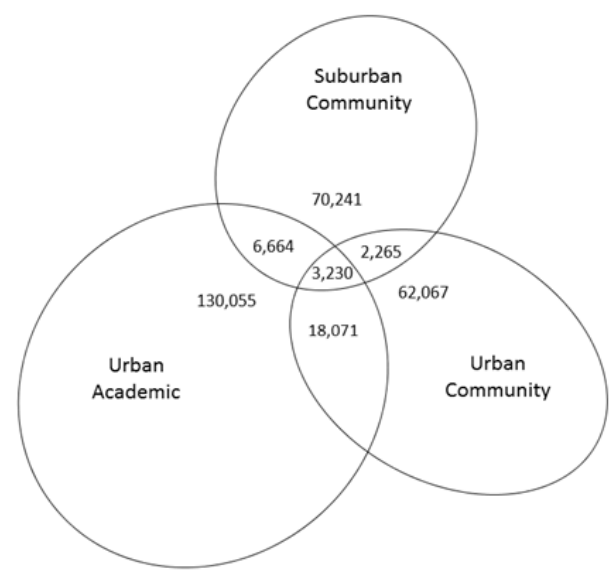
Figure. Overlap between emergency department patient populations. Of all patients receiving emergency care (n=282,903), the proportion who were seen in only one emergency department (ED) or in various combinations of multiple EDs over a five-year period. Size of oval and overlapping sections are proportional to number that each section represents.